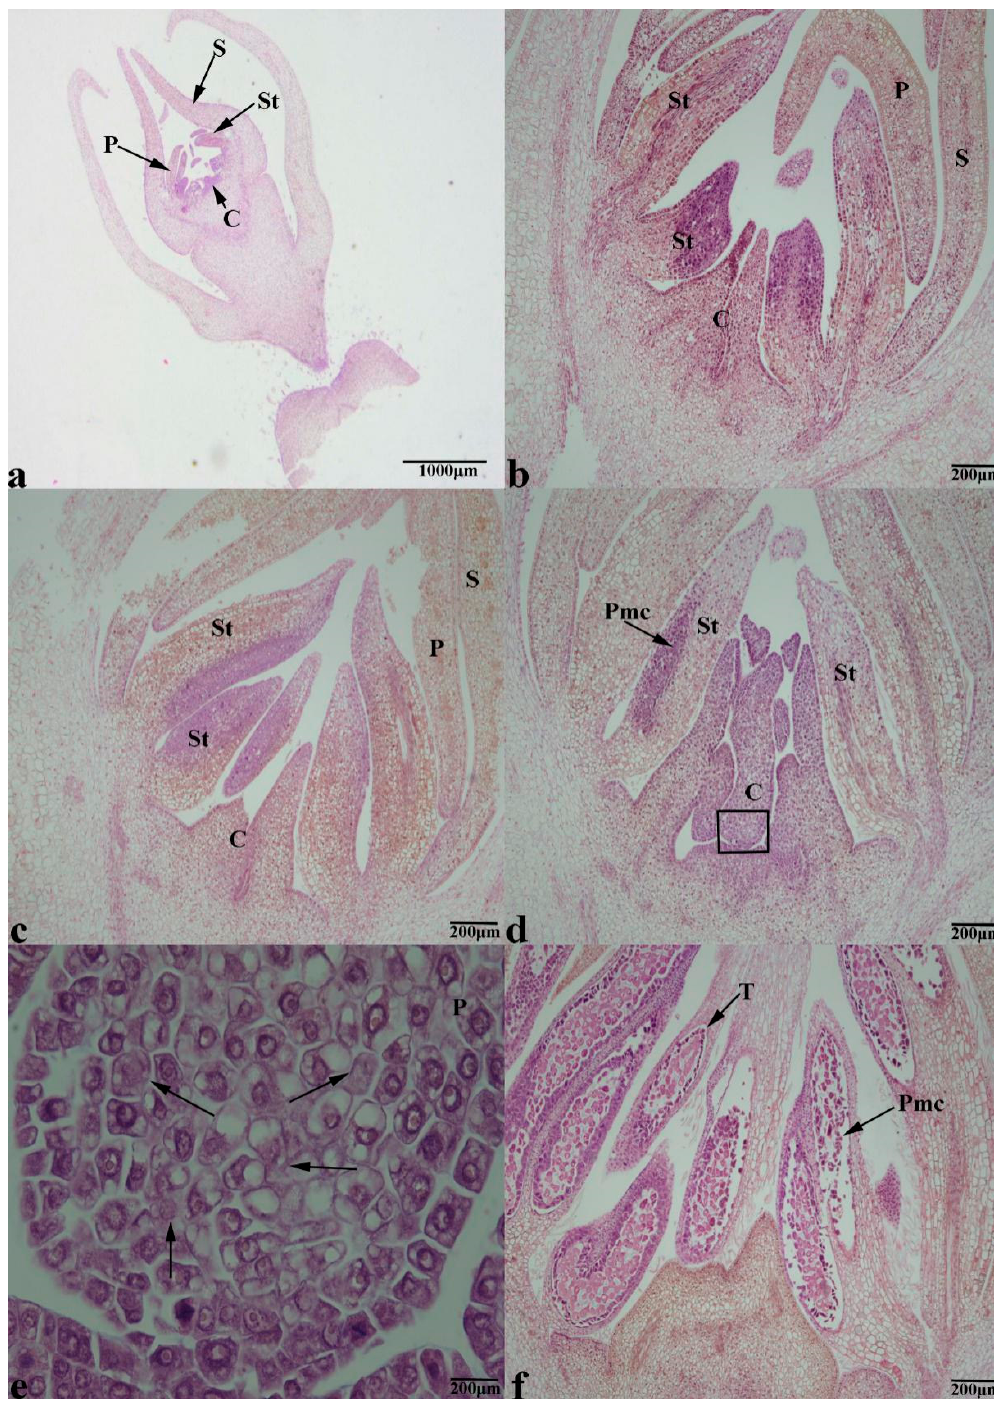
Figure 3. Hematoxylin and eosin (H&E) staining of male floral buds during differentiation in persimmon. ( a ) Sample at the carpel primordium differentiation stage harvested on April 5, 2017. ( b ) Sample at the anther primordium differentiation stage harvested on April 8, 2017. ( c ) Details of the pollen sac and filaments harvested on April 11, 2017. ( d ) Details of the microsporocyte harvested on April 14, 2017. ( e ) Carpel from the rectangle magnified in ( d ) (arrows indicate dead cells). ( f ) Details of the male floral bud harvested on April 17, 2017. (C = carpel; P = petal; Pmc = pollen mother cell; S = sepal; St = stamen; T = tapetum).